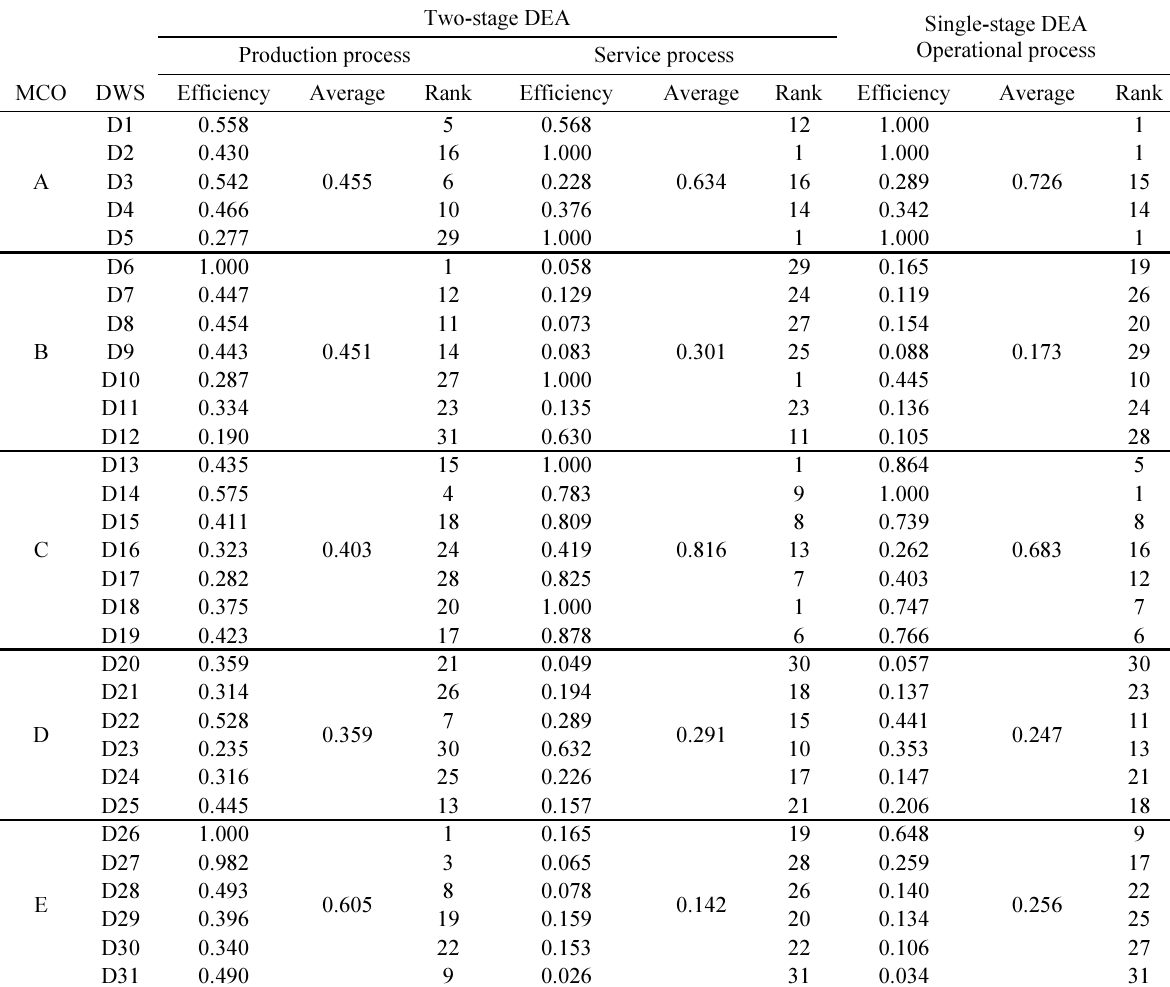
Table 7. Efficiencies of production, service and operational processes and their rankings